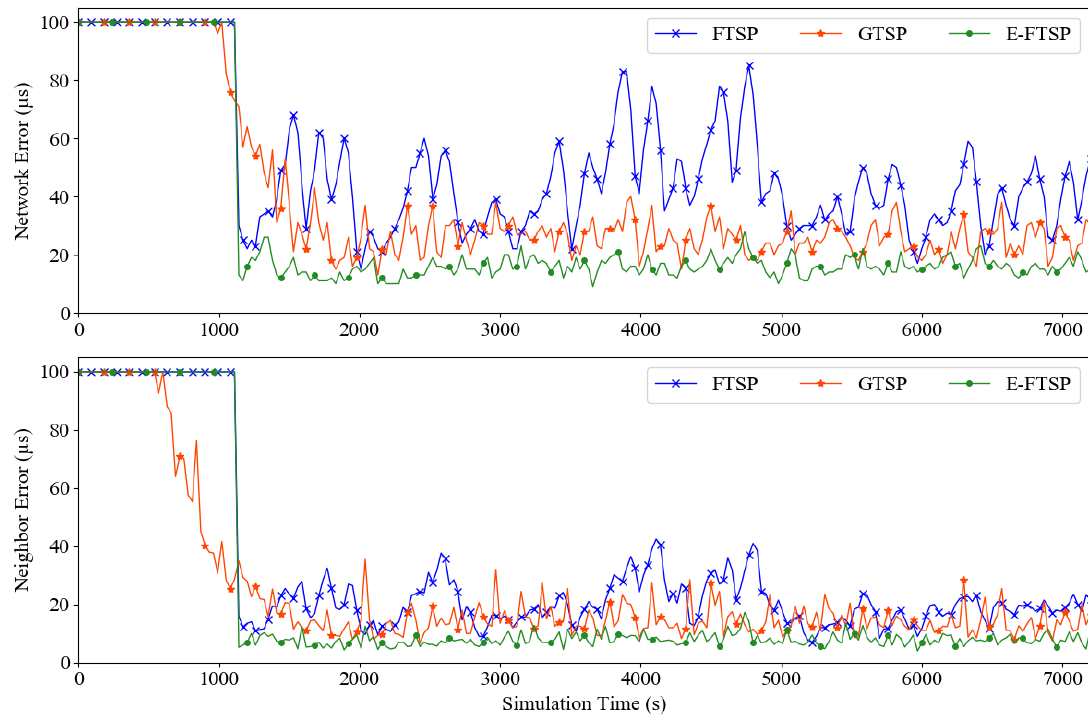
Figure 6. Network errors and maximum neighbor errors of FTSP, GTSP, and E-FTSP in the presence of message delay